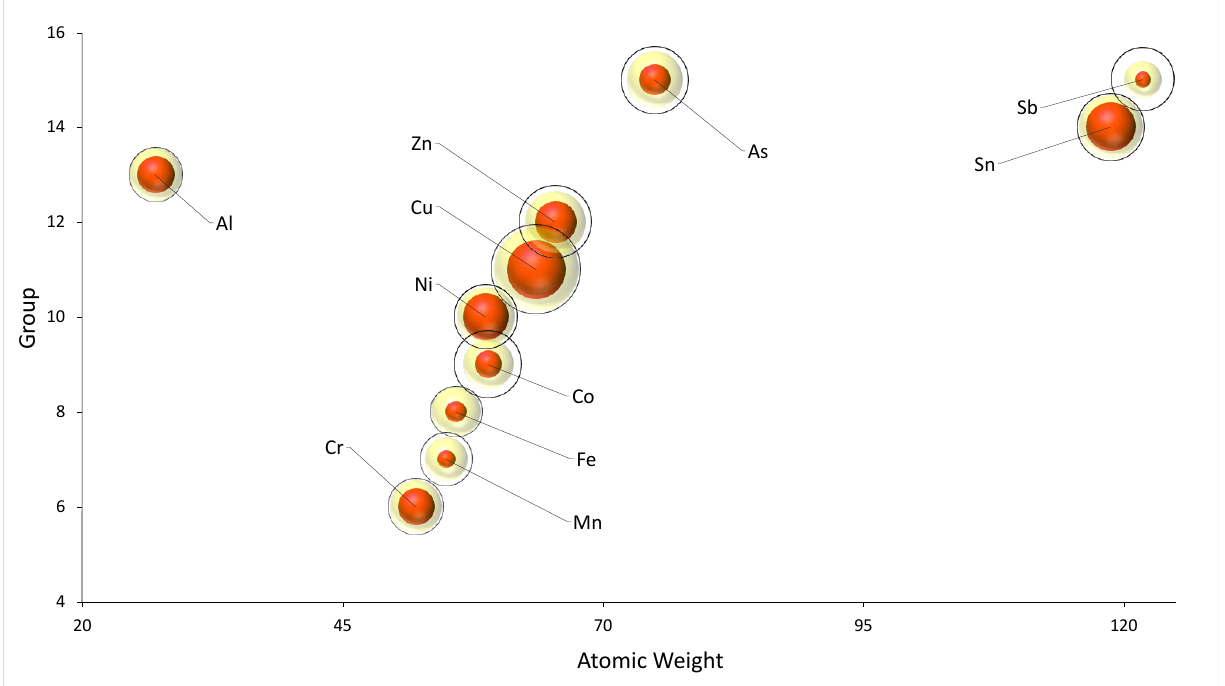
Figure 3. Bubble graph of the leaching tests performed on the different samples. Each bubble is the average of the concentrations determined for each sample in the leaching tests, after normalization. The red bubbles identify the test performed after 24 h, the yellow bubbles after 7 days, and the black circles after 15 days.